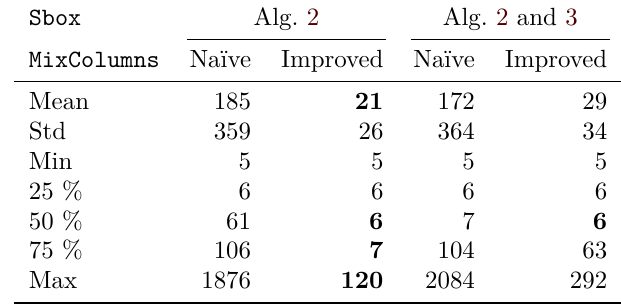
Table 12: Computation time (sec) for 32 rounds of Skinny -128 on a sample of 1975 input/output pairs.